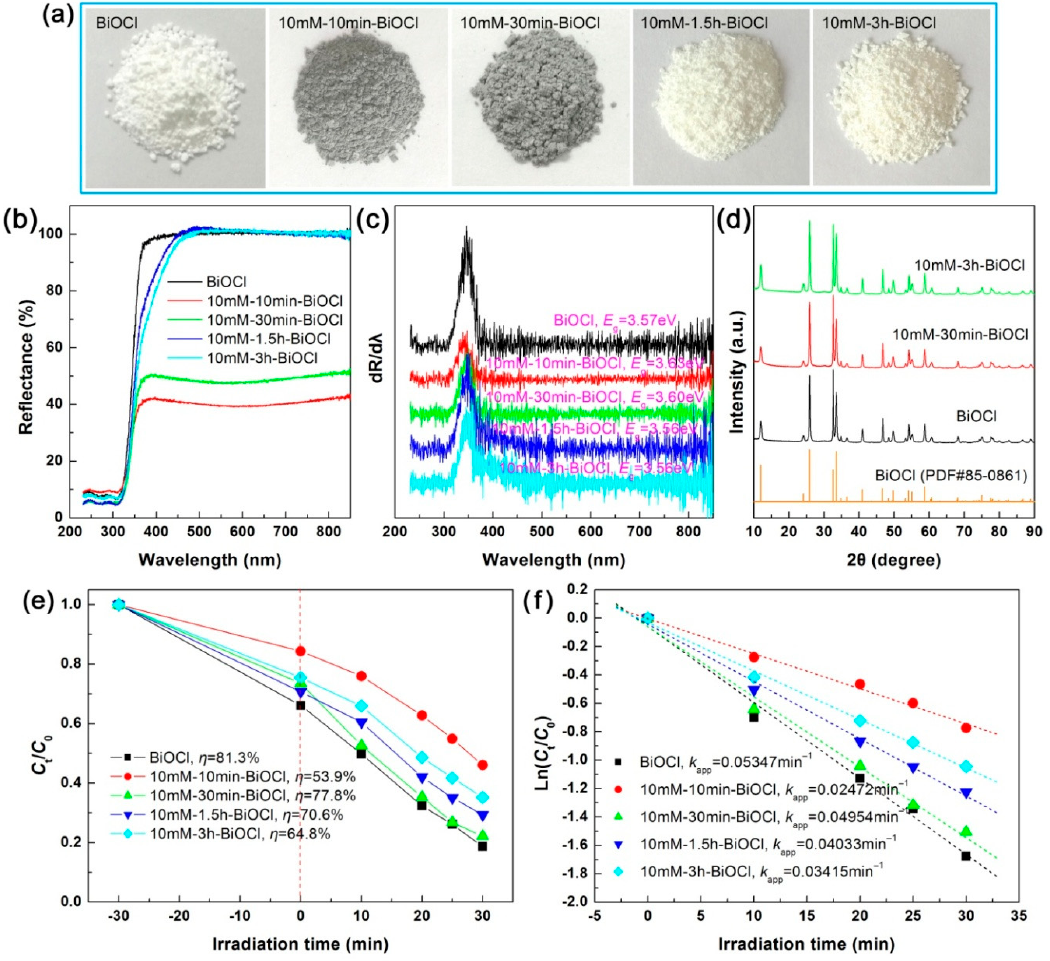
Figure 9. Apparent colors ( a ), UV-vis diffuse reflectance spectra ( b ), first derivative curves of the UV- vis diffuse reflectance spectra ( c ), XRD patterns ( d ), time-dependent photodegradation of RhB ( e ), and kinetic plots of the dye degradation ( f ) for the 10 mM NaBH4-treated BiOCl samples with different treatment times.